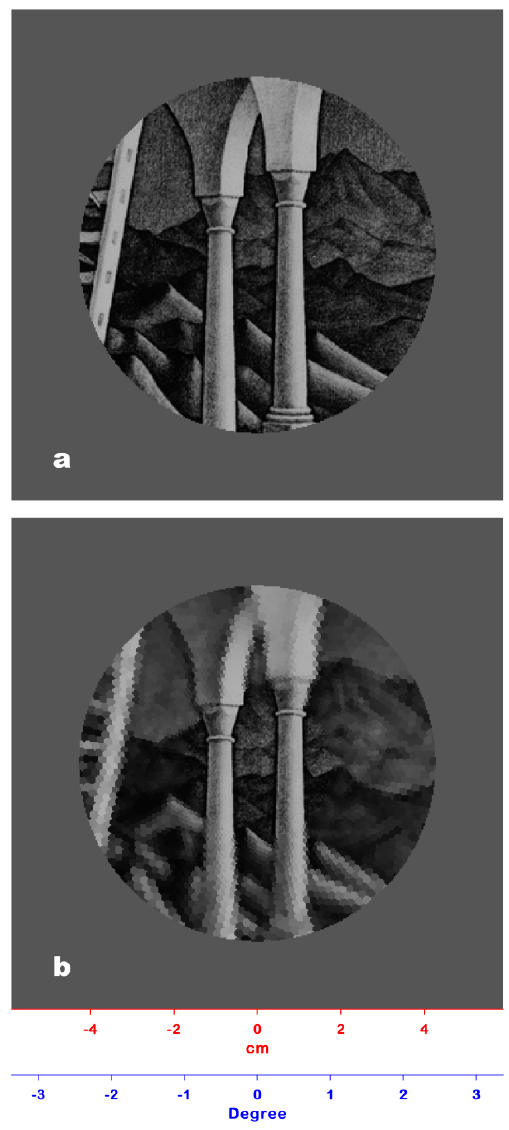
Figure 4. ( a ) The stimulus used in Experiment #3: The Belvedere lithograph overlaid with a window of a 42.80 mm radius showing only a detail of the artwork and blocking all the peripheral information. For the sake of clarity, only a part of the lithograph is shown. ( b ) The PRI of Figure 4a: Since the loss of spatial resolution within the window is minimal, any 3D incoherence present herein would have been pre-attentively perceived.